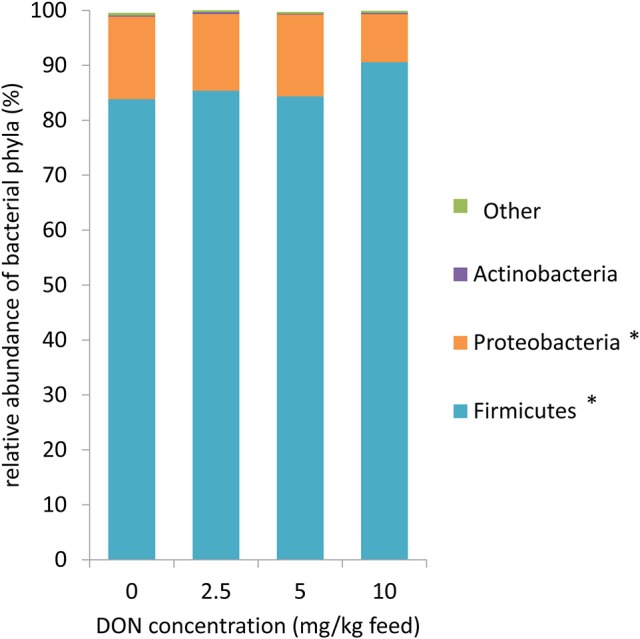
Microbiome composition at phylum level for 16S rRNA sequences in cecal digesta of broiler chickens fed diets with increasing levels of deoxynivalenol (DON; 0, 2.5, 5, or 10 mg DON/ kg diet). Values are presented as least squares means ± standard error of the mean (SEM); n = 20 broilers per feeding group. Presented data include both animals with and without oral lipopolysaccharide challenge (LPS) 1 day prior to slaughter within the respective feeding group. Data were not affected by LPS and DON × LPS (p > 0.10). * Linear contrast: p < 0.10.